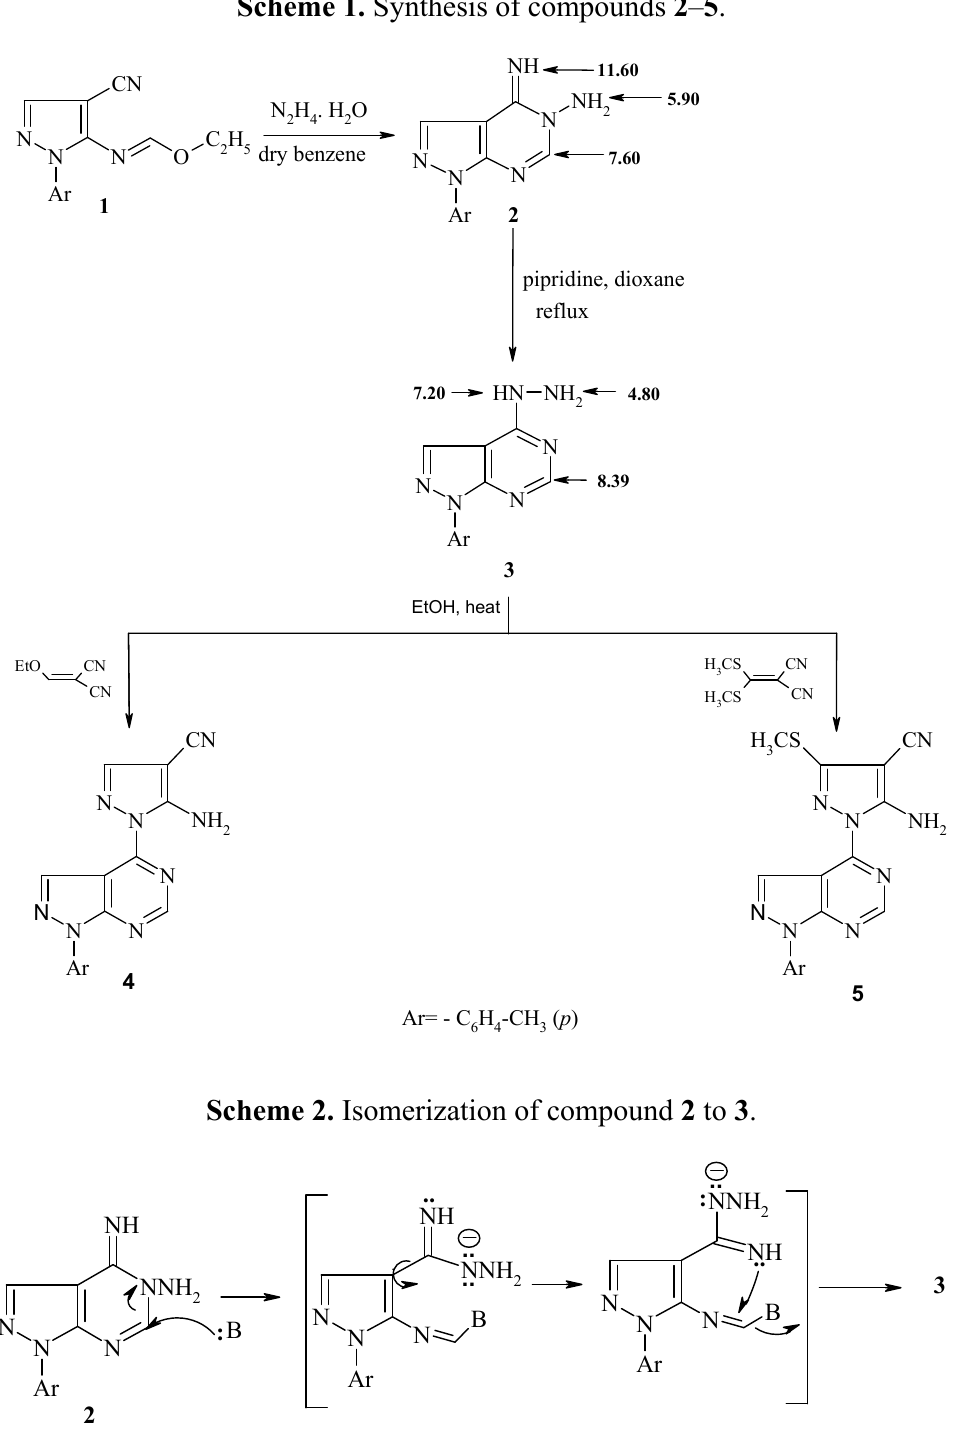
Scheme 1. Synthesis of compounds 2 – 5 .